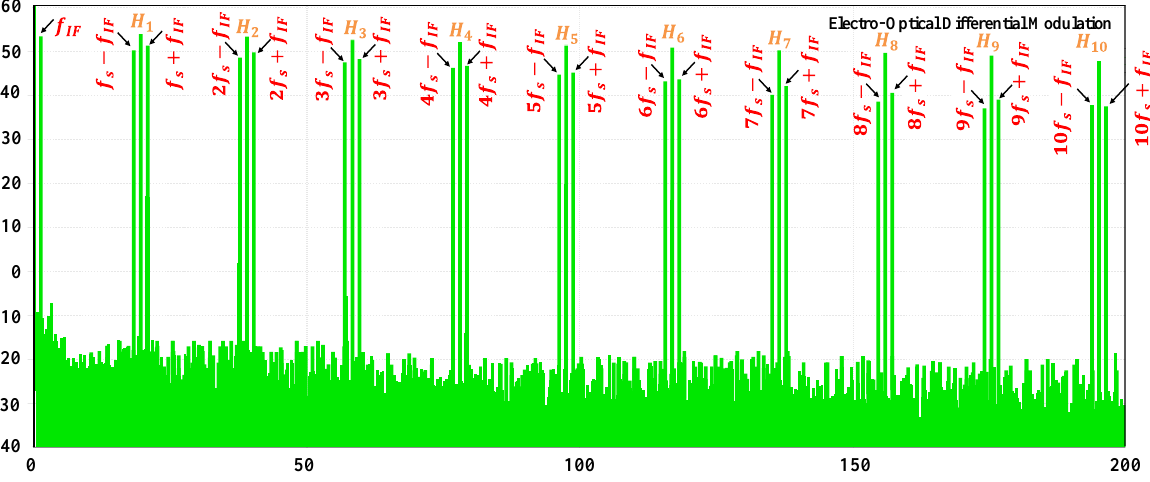
Figure 3. Electrical spectrum that represents the power in dBm of the signal to be mixed at the outer port of SOA–MZI versus the mixing frequencies nf s ± f IF in GHz for the modulation of differential mode.